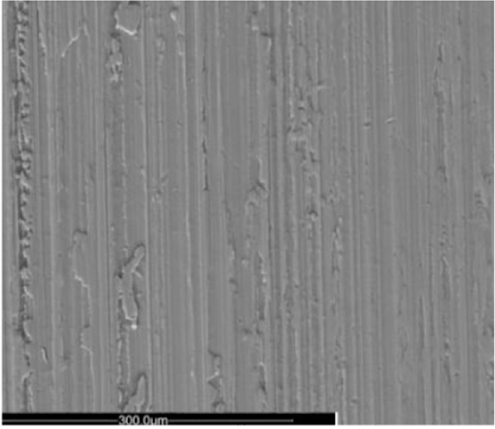
Figure 12. Abrasive wear tracks of NiTec coatings deposited at 14.72 SCFH.